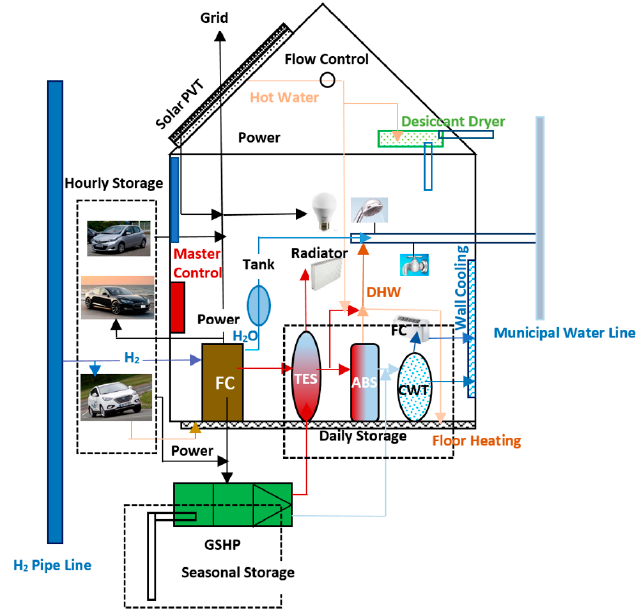
Figure 12. All DC-Solar-Central Hydrogen Hybrid Net-Zero/Positive Exergy Building.